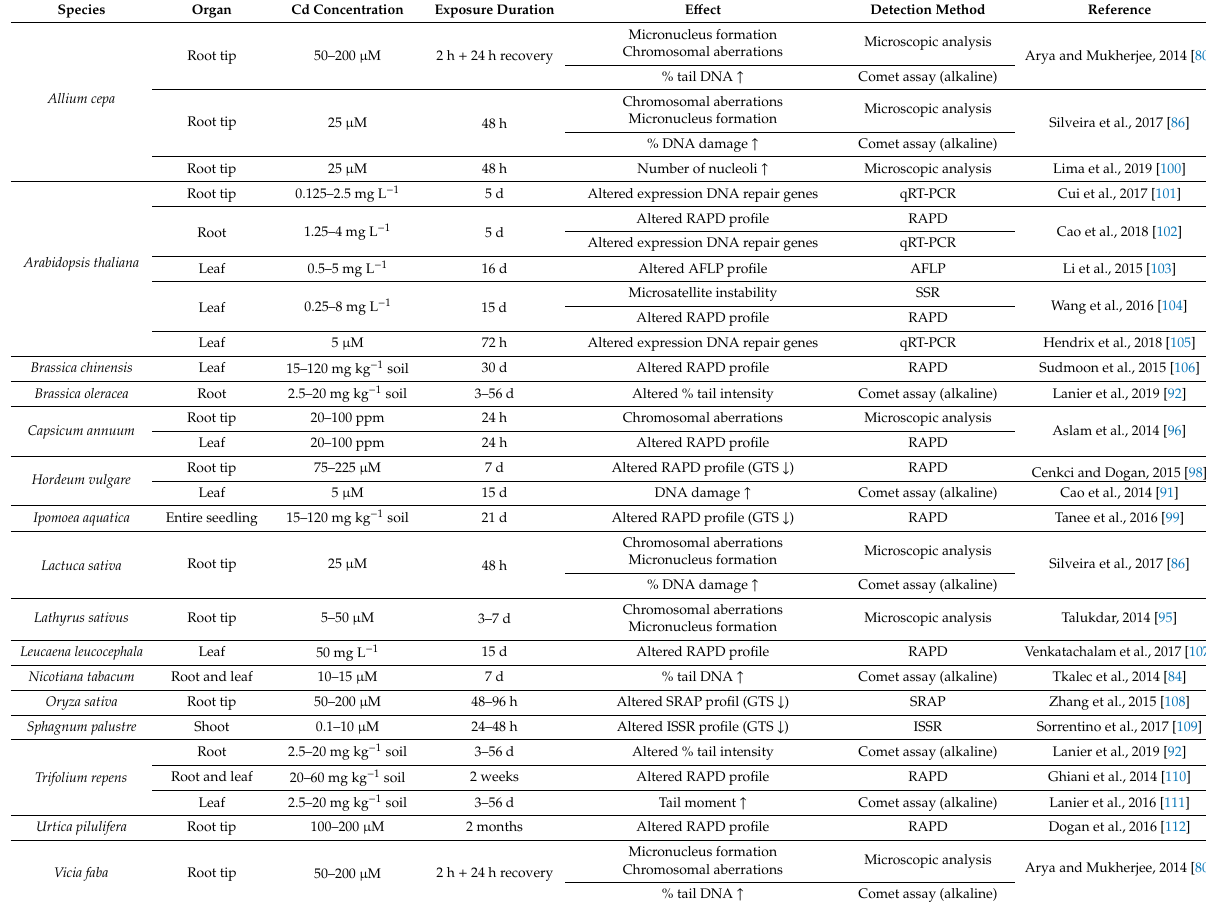
Table 1. Overview of recent research articles (published since 2014) demonstrating Cd-induced DNA damage, arranged by plant species. Cadmium is shown to induce di ff erent types of DNA damage, including DNA strand breaks, chromosomal aberrations and micronuclei in di ff erent plant species. Furthermore, it alters the expression of DNA repair genes and changes amplified fragment length polymorphism (AFLP), inter-simple sequence repeat (ISSR), random amplified polymorphic DNA (RAPD), sequence-related amplified polymorphism (SRAP) and simple sequence repeat (SSR) profiles, thereby reducing the genomic template stability (GTS). ↑ and ↓ symbols indicate increases and decreases,